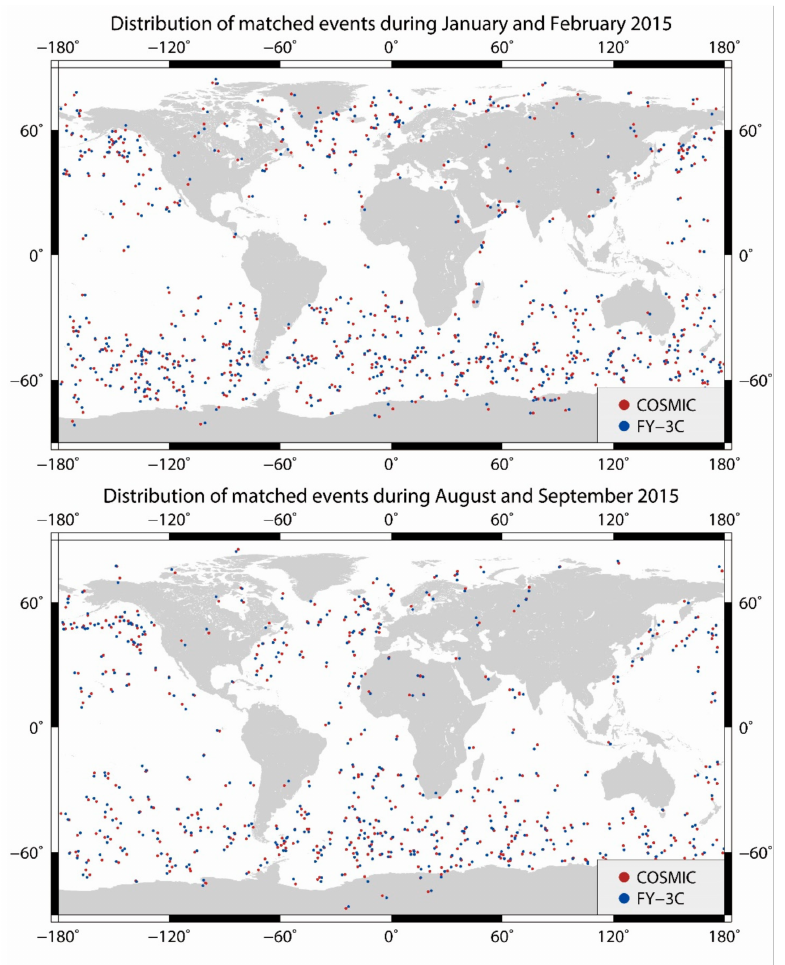
Figure 1. Global distribution of the matched RO events between FY-3C and COSMIC. The red marks represent COSMIC events and the blue marks represent FY-3C events. The top panel shows the distribution in January and February 2015, the bottom panel shows the distribution in August and September